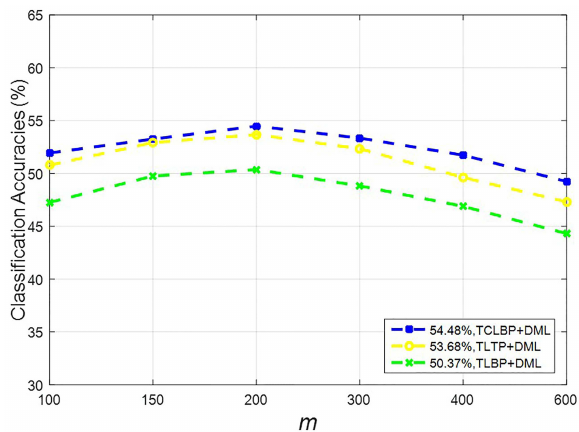
Figure 11. Performance of the proposed methods under different m